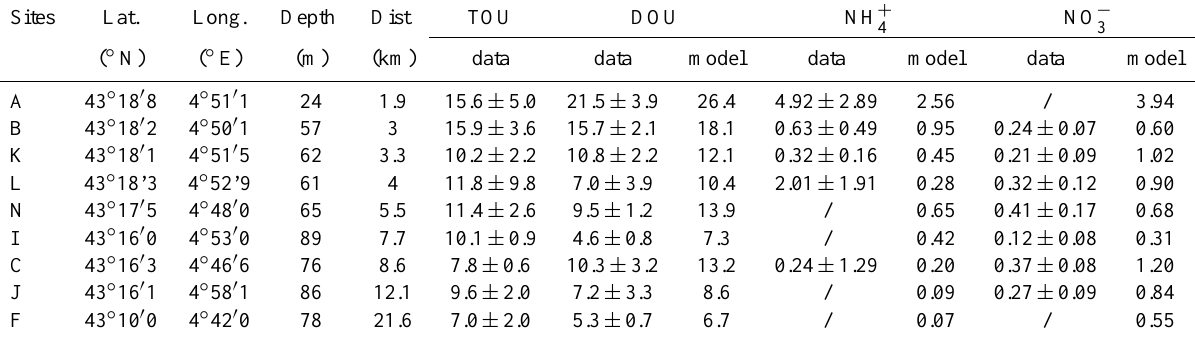
/: no data. Standard deviations are determined from 2 or 3 cores.